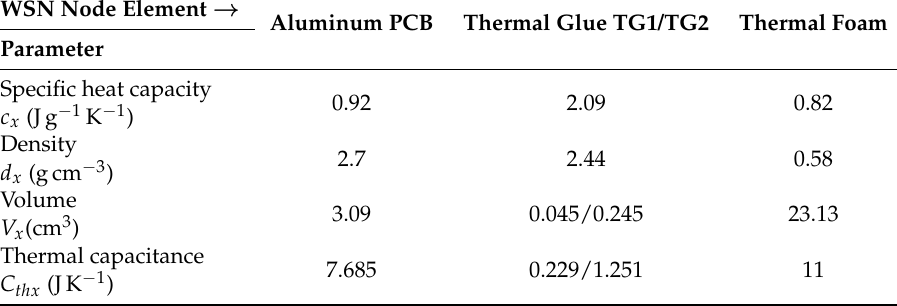
Table 3. Thermal capacitances of the WSN node elements.